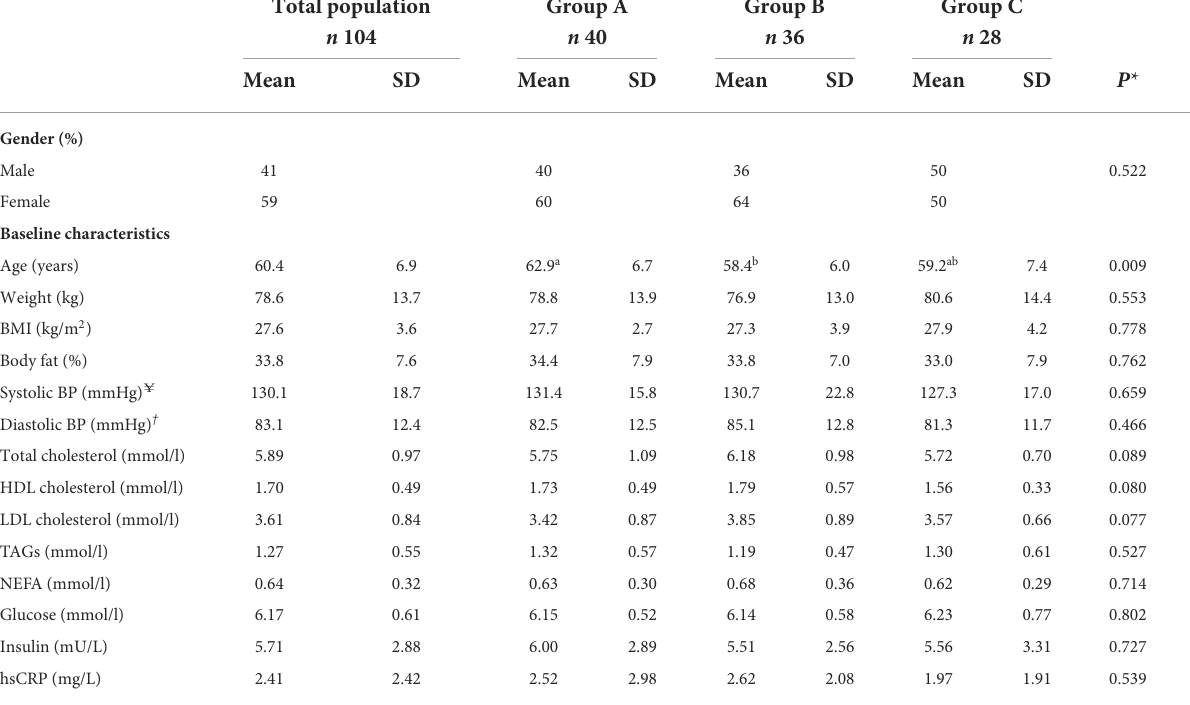
TABLE 1 Baseline demographic and phenotypic characteristics of the total population and by intervention groups A–C. Total population Group A Group B Group C n 104 n 40 n 36 n 28 Mean SD Mean SD Mean SD Mean SD P